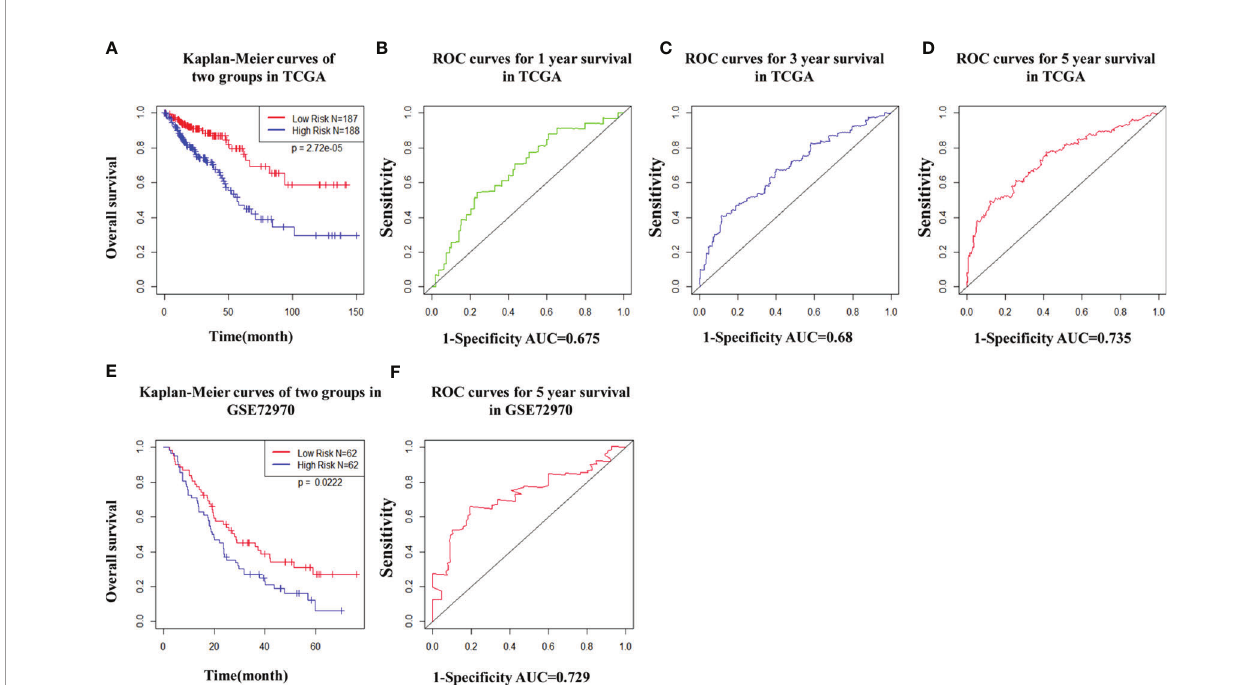
FIGURE 7 | The distribution of time-dependent receiver operating characteristic (ROC) curves and Kaplan-Meier survival based on the integrated classi fi er in The Cancer Genome Atlas (TCGA) and gene set enrichment. (A) Kapan-Meier curve of the TCGA cohort. (B – D) ROC curves for 1-year, 3-year, and 5-year survival in the TCGA cohort. (E) Kapan-Meier curve of the gene set enrichment cohort. (F) ROC curve for 5-year survival in the gene set enrichment cohort. ROC, receiver operator characteristic; AUC, the area under the